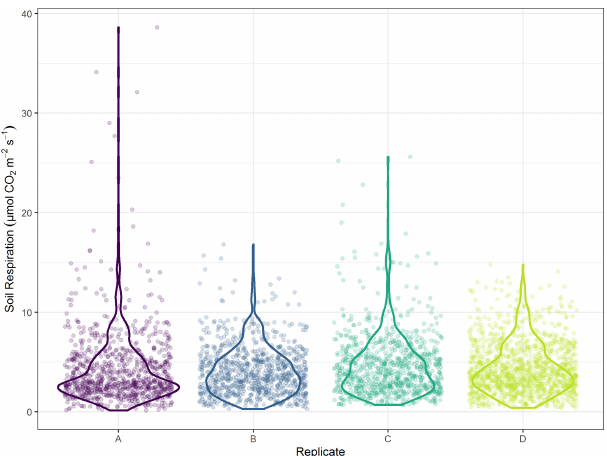
Figure 4. Distribution of soil CO 2 efflux values from May– November 2019 by replicate. Lines represent distribution, while points are individual measures.